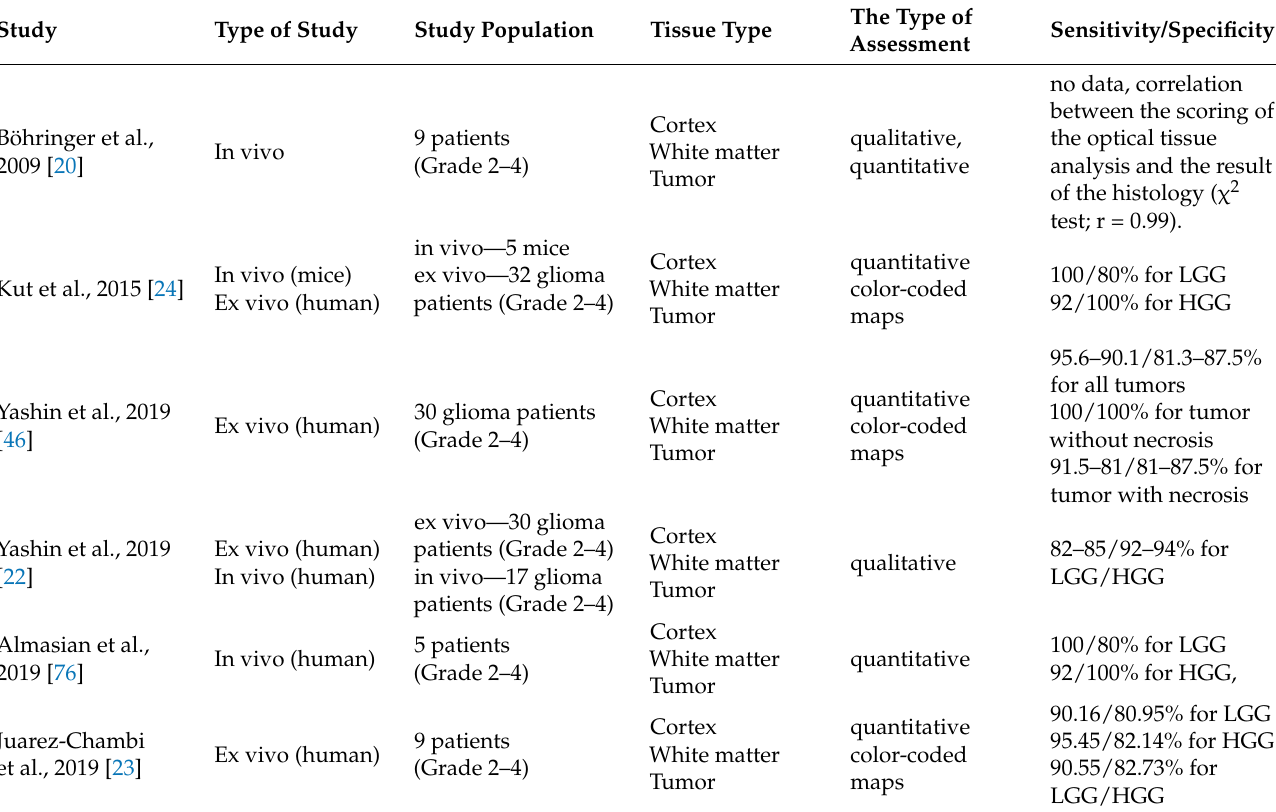
Table 1. Sensitivity and specificity of OCT in distinguishing tumorous and non-tumorous